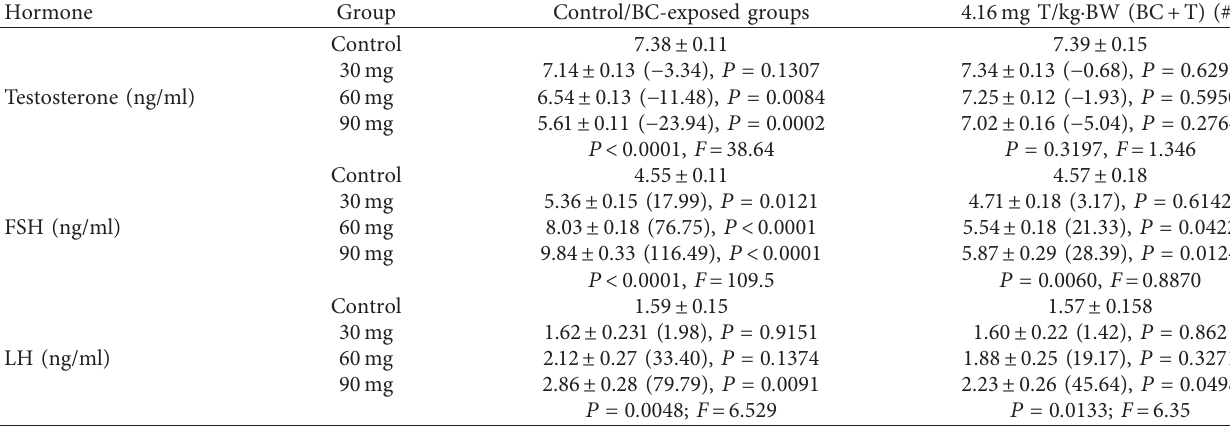
Table 4: Administration of testosterone on the levels of serum testosterone (T), follicle stimulating hormone (FSH), and luteinizing hormone (LH) of adult male Wistar mice exposed to baicalein (BC) prenatally.